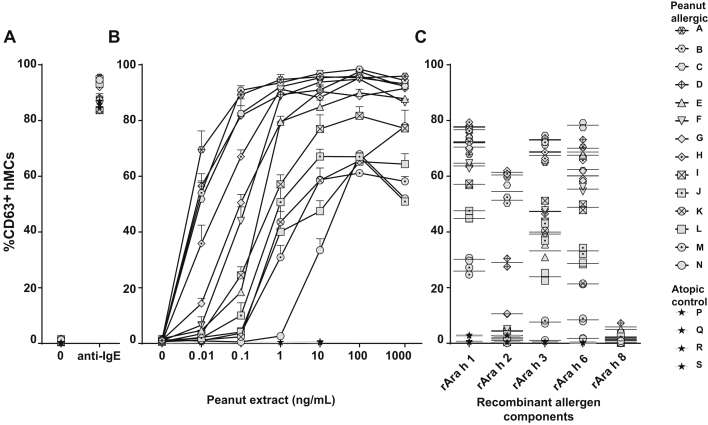
hMC degranulation using hMCs from patients with peanut allergy. hMCs were sensitized overnight with sera of patients with peanut allergy or control sera (volume ratio, 1:10), washed, and either left untreated or exposed for 1 hour to anti-IgE (10 μg/mL; A), different concentrations of peanut extract (as indicated; B), or recombinant peanut allergens (rAra h 1, rAra h 2, rAra h 3, rAra h 6, and rAra h 8 [10 nmol/L]; C). hMC degranulation was measured by using CD63 surface staining and analyzed with flow cytometry. Fig 2, A and B, show one representative experiment of 2, and the assay was performed in duplicates or triplicates with pooled hMCs from at least 3 different healthy donors. Values indicate means ± SDs, and symbols show individual subjects. In Fig 2, C, the assay was performed in duplicates; lines indicate the mean of replicates, and symbols show each subject.